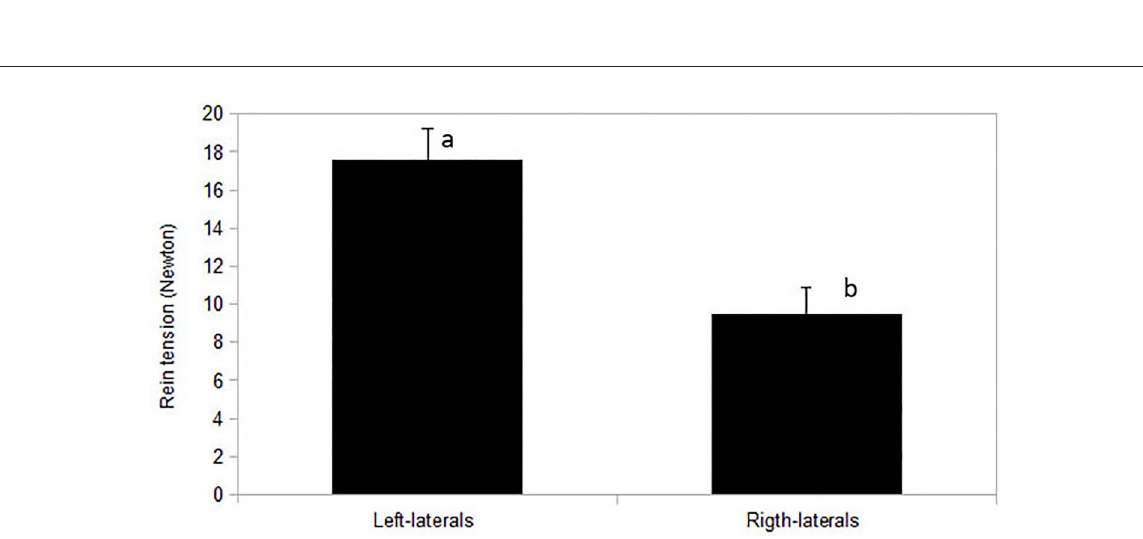
left-lateral horses (RiderAssessment) was considerably higher than in right-lateral horses (RiderAssessment) (mean of both reins: 17.6 ± 2.5N LL vs. 9.5 ± 1.5 N RL, p = 0.02, Figure 6). The difference between tension in the left and right rein was higher when riding in direction of the riders’ non-dominant hand (counter-clockwise) with all horses ( p = 0.02). Rein tension was more stable (i.e., lower ReinTensionSD) when riding in the direction of the riders’ dominant hand (clockwise; p <